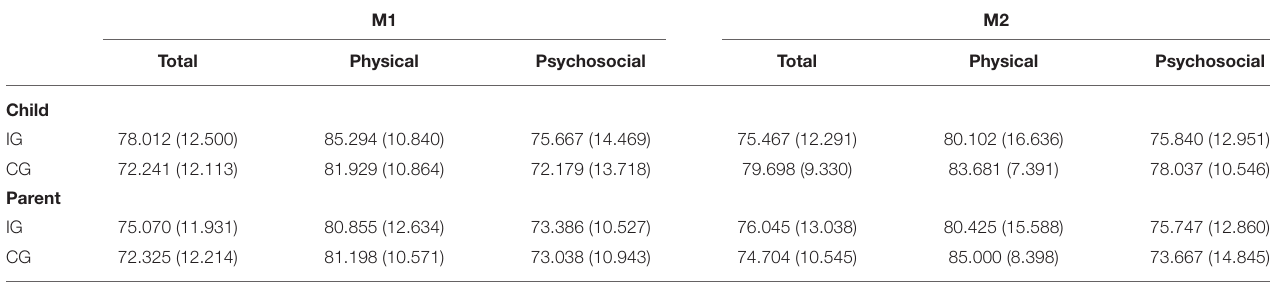
TABLE 6 | M (SD) of the PedsQL at the respective measurement points.